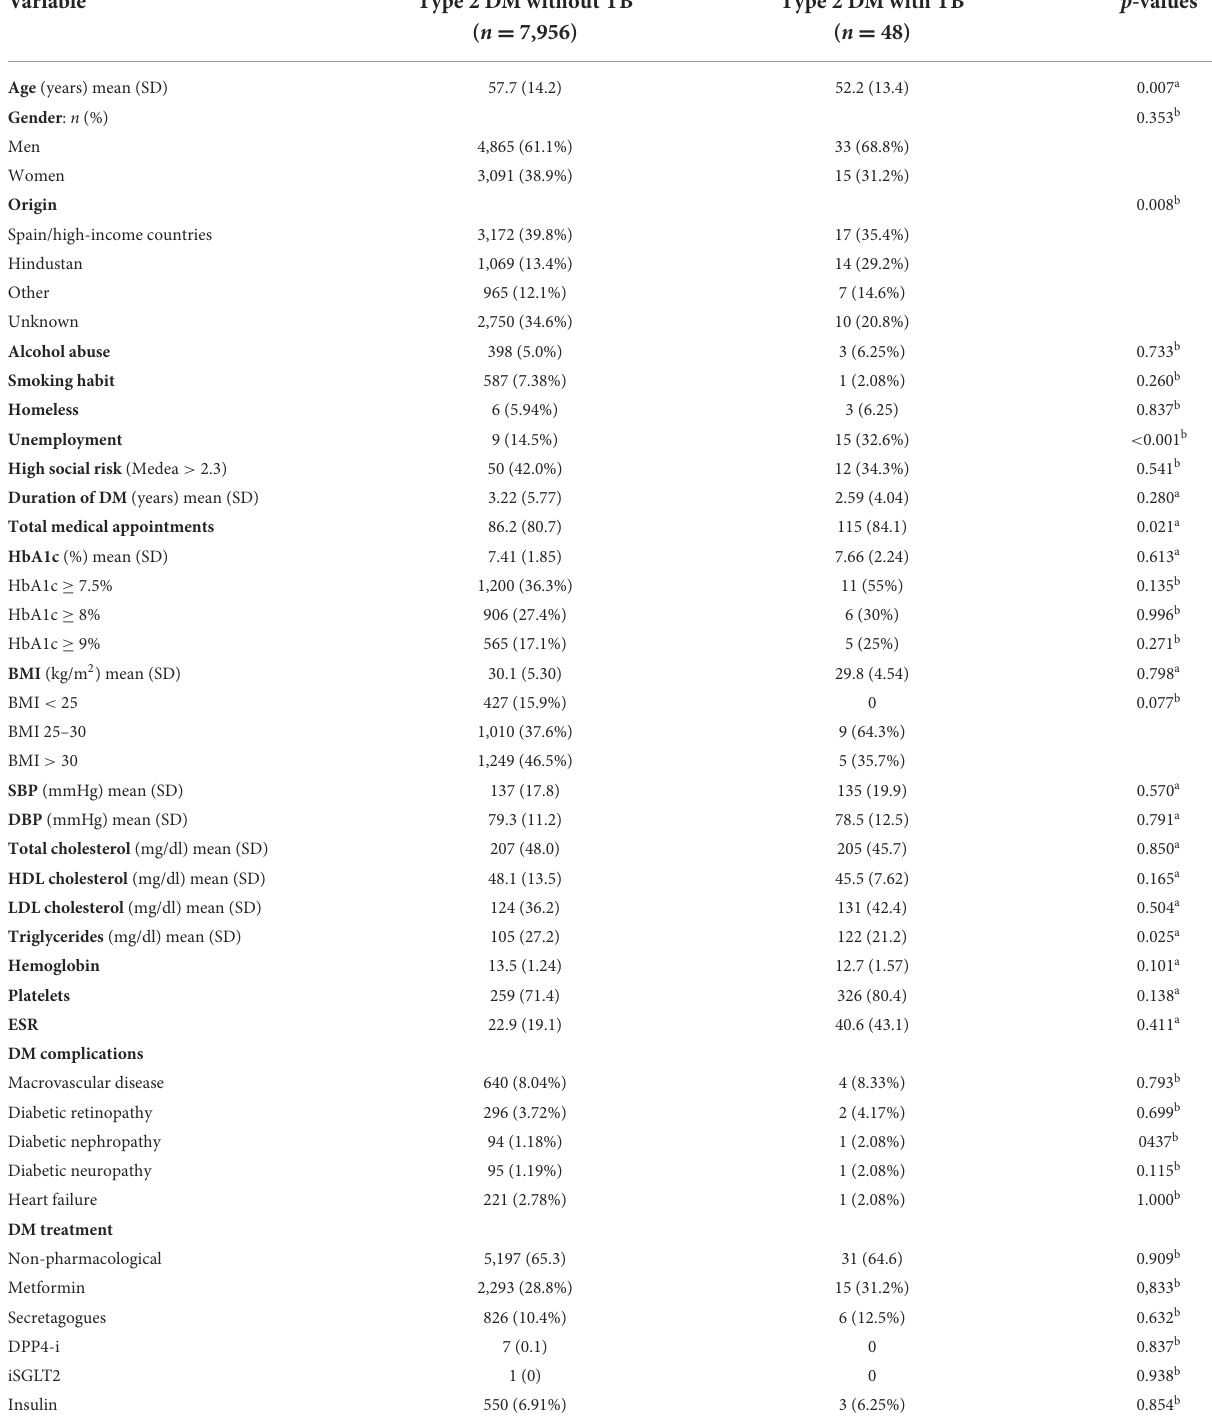
TABLE 1 Baseline characteristics of the study variables in diabetic patients without and with the occurrence of tuberculosis during the follow-up period.